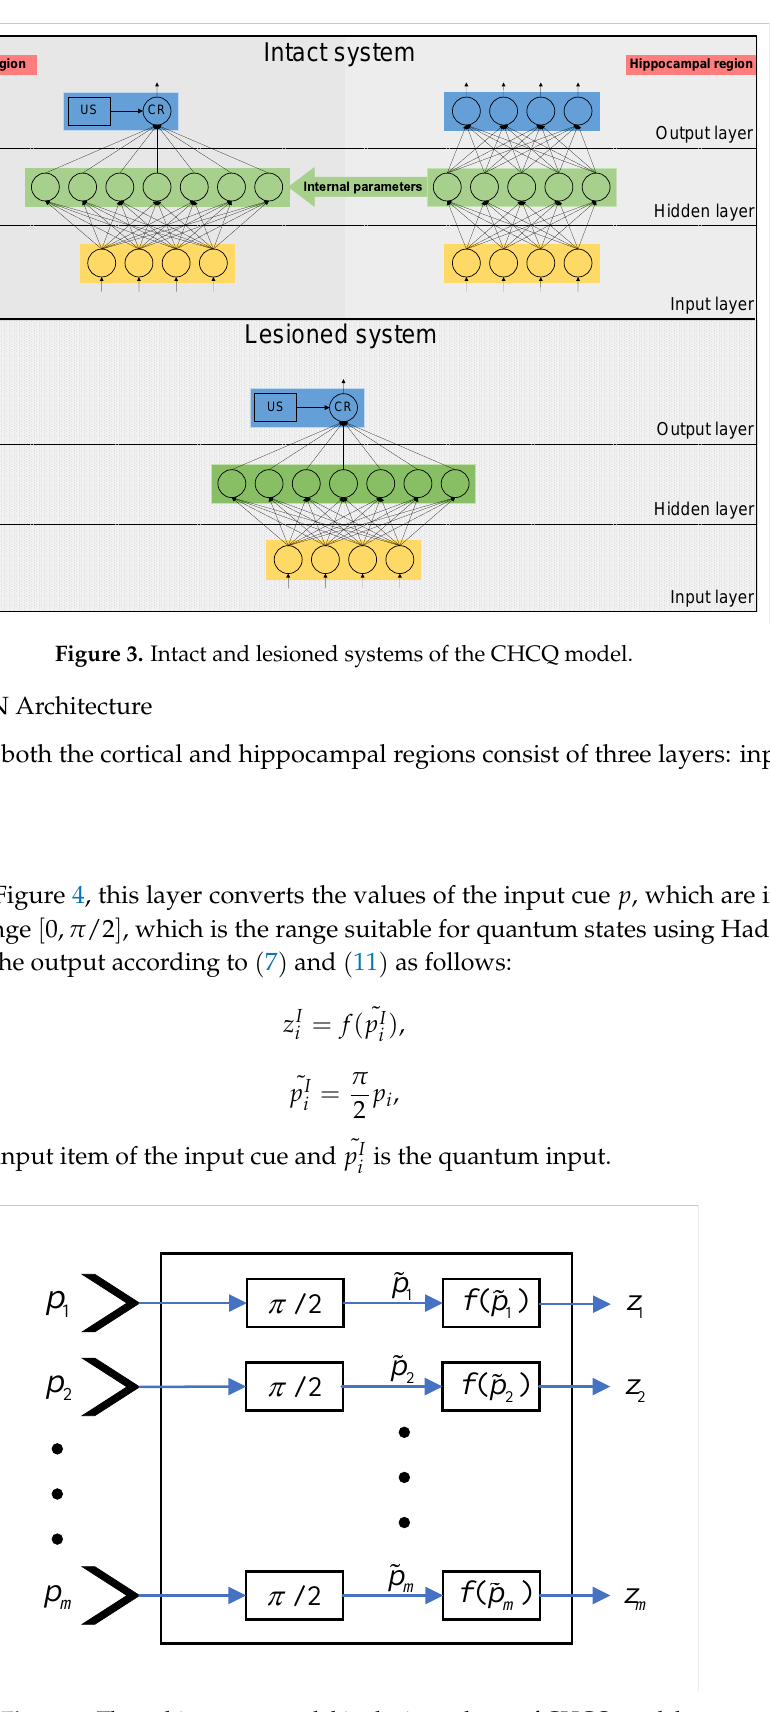
Figure 4. The qubit neuron model in the input layer of CHCQ